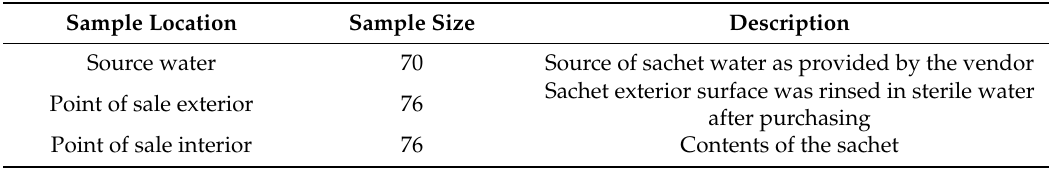
Table 1. Description of water sampling at three